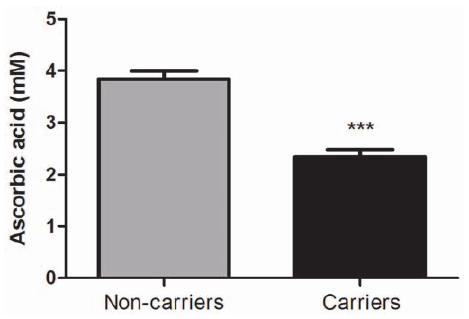
Figure 4. Ascorbic acid (vitamin C) content in plasma. Ascorbic acid content in plasma from TP53 p.R337H mutation carriers (n=16) and non-carriers (n=16). Data represent the mean 6 S.E.M, (***) P , 0.0001 (Student t Test for unpaired samples).